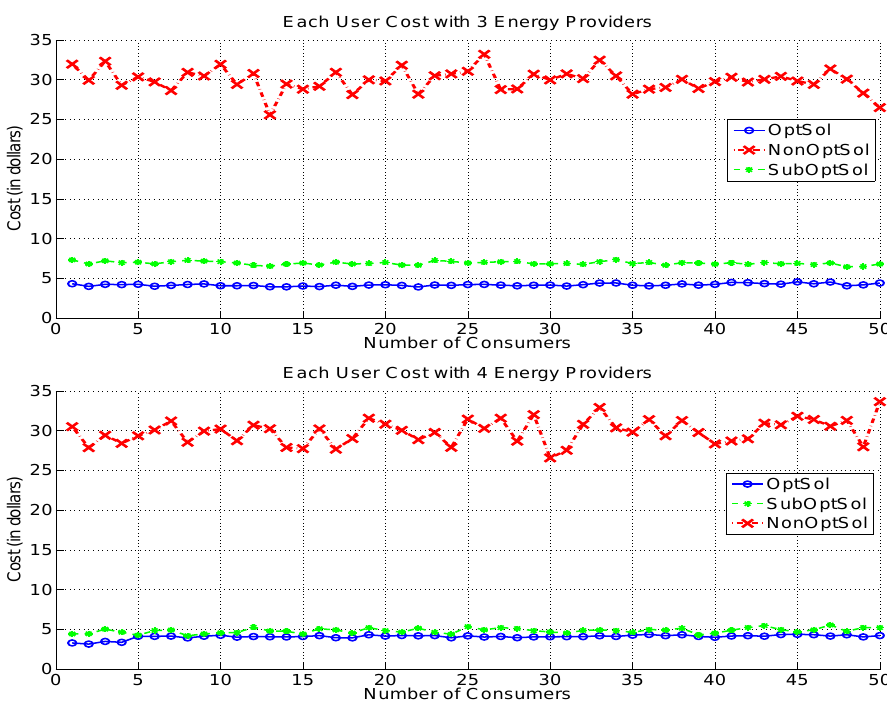
Figure 8. Fair Cost Minimization versus Number of Energy Sources for N = 3 and N = 4.